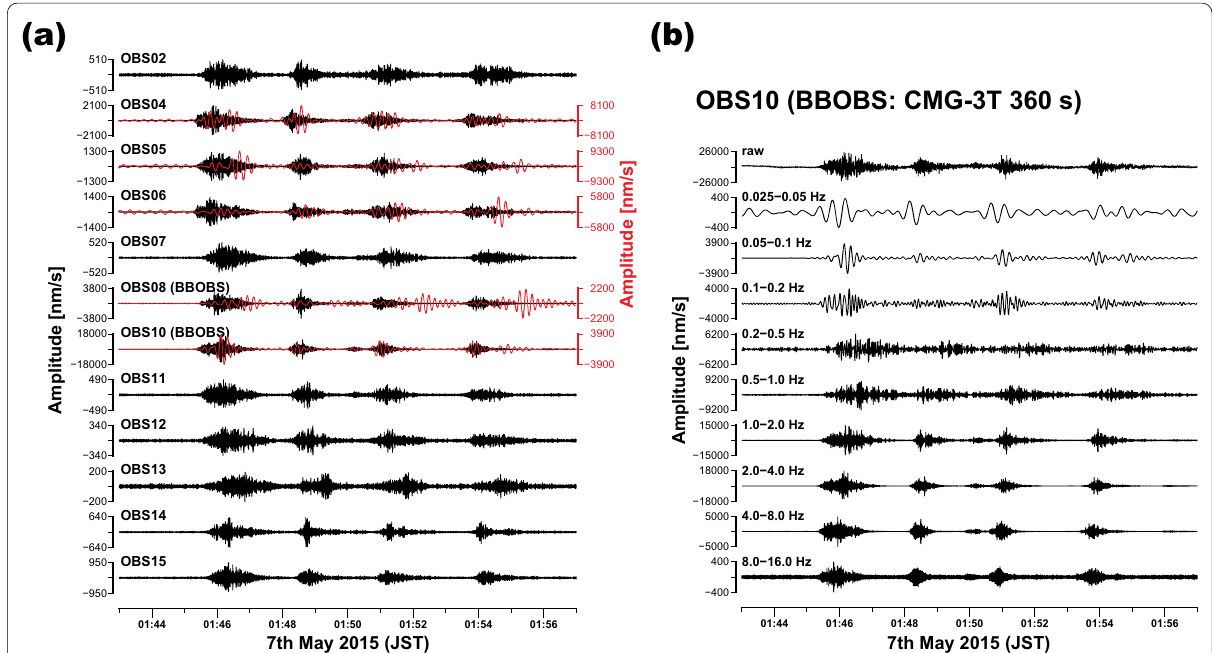
Fig. 2 Example waveform from the 2nd observation period showing: a the bandpass-filtered waveform in the tremor (2–4 Hz: black) and the VLFE (0.05–0.1 Hz: red) bands for 14 stations (numbers indicate the OBS stations shown in Fig. 1). The instrumental responses have been corrected. Red traces (VLFE band) are plotted only for stations where a signal was obtained above the noise level. Each trace was normalized based on the maximum amplitude and b bandpass-filtered waveforms for different bands observed by the BBOBS (OBS 10). The uppermost waveform is the raw data, while the others were filtered using the bands displayed to the